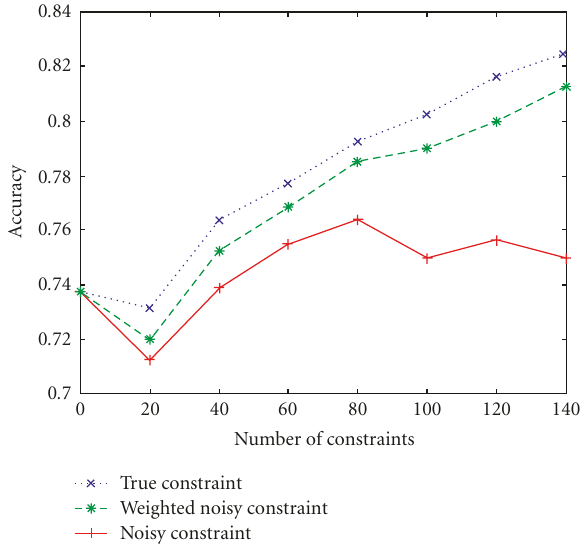
Figure 4: Accuracy with di ff erent numbers of